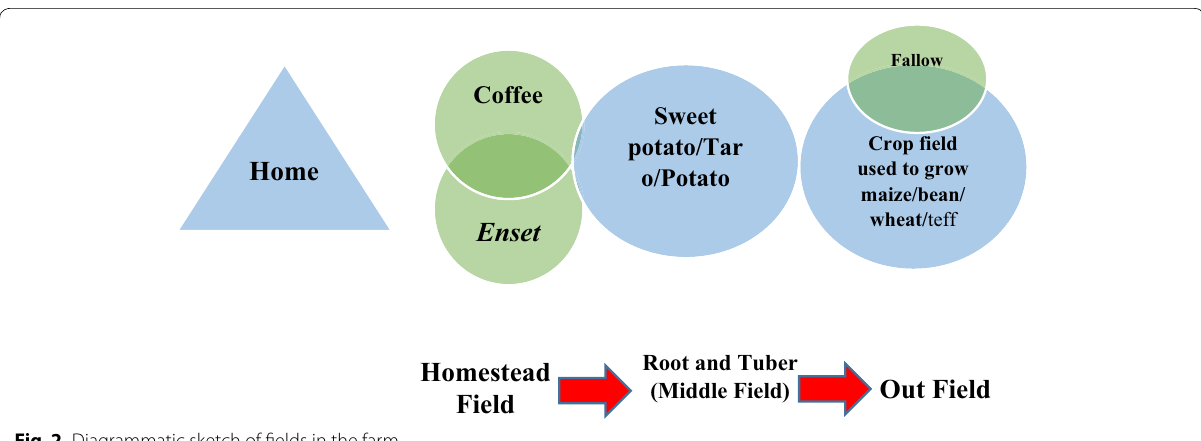
Fig. 2 Diagrammatic sketch of fields in the